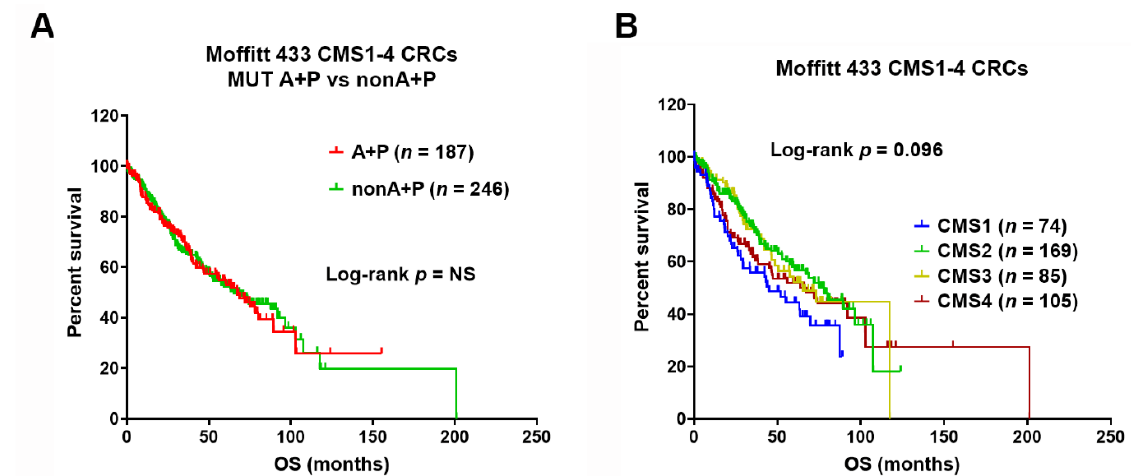
Cancers 2021 , 13 , x FOR PEER REVIEW Figure 3. ( A ) Kaplan–Meier (KM) overall survival (OS) analysis by MUT APC + TP53 (A + P) ( n = 187) vs. non-A + P ( n = 246) in Moffitt 433 CMS1-4 CRC tumors. ( B ) KM OS analysis across four CMS classes in 433 CMS1-4 CRCs.